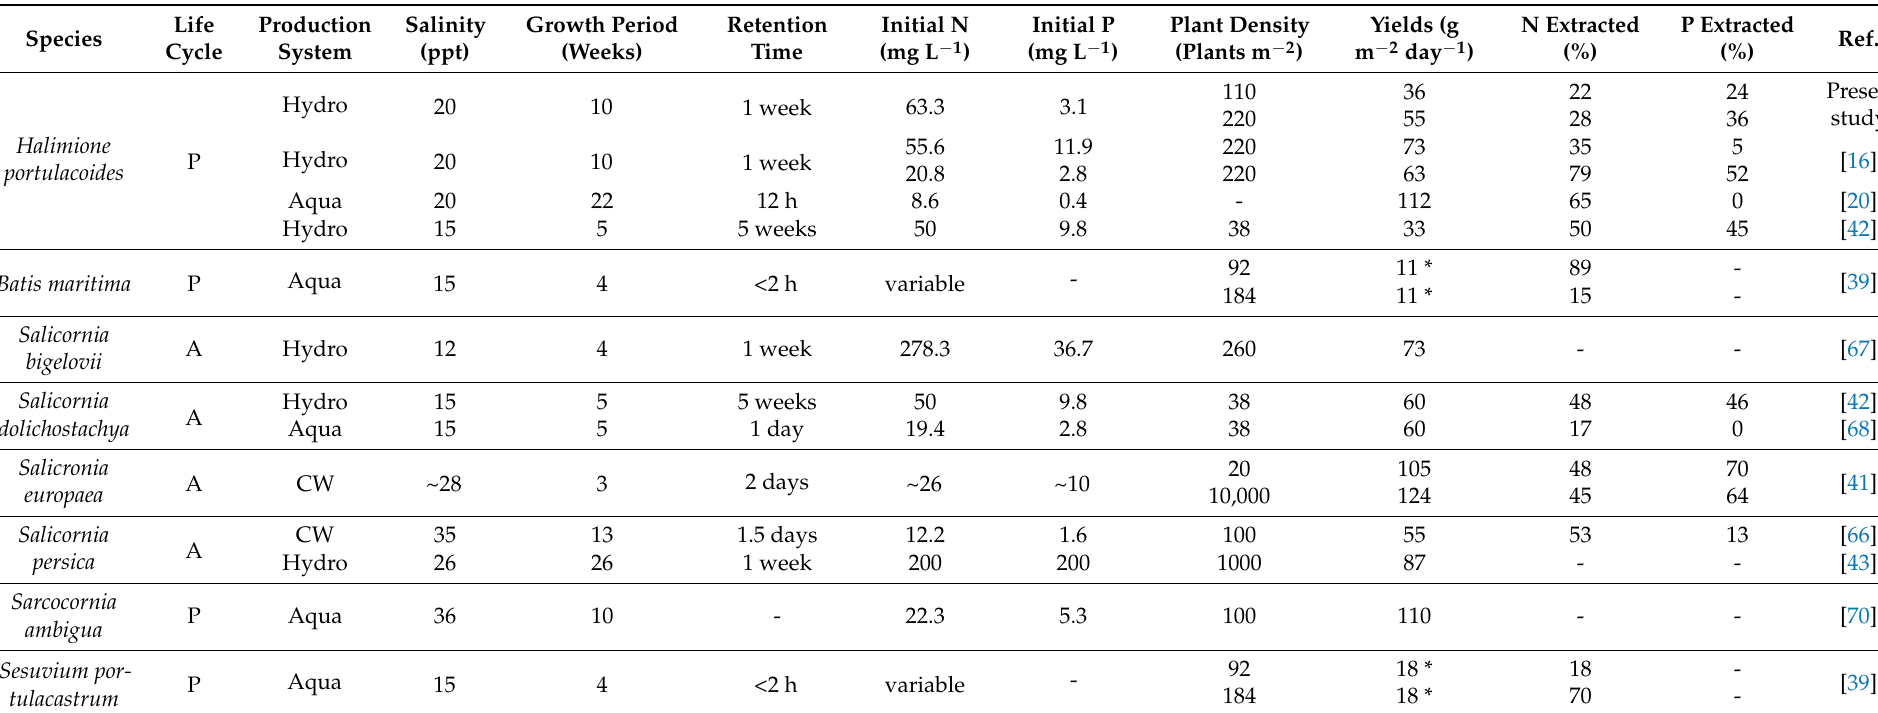
Table 5. Growth and extractive performances of halophyte species under different plant densities. Note: average values and parameters were retrieved, calculated, or estimated from data reported in the referenced publications reported in the methods, tables and/or graphics. A—annual, P—perennial, Aqua—aquaponics, Hydro—hydroponics, CW—constructed